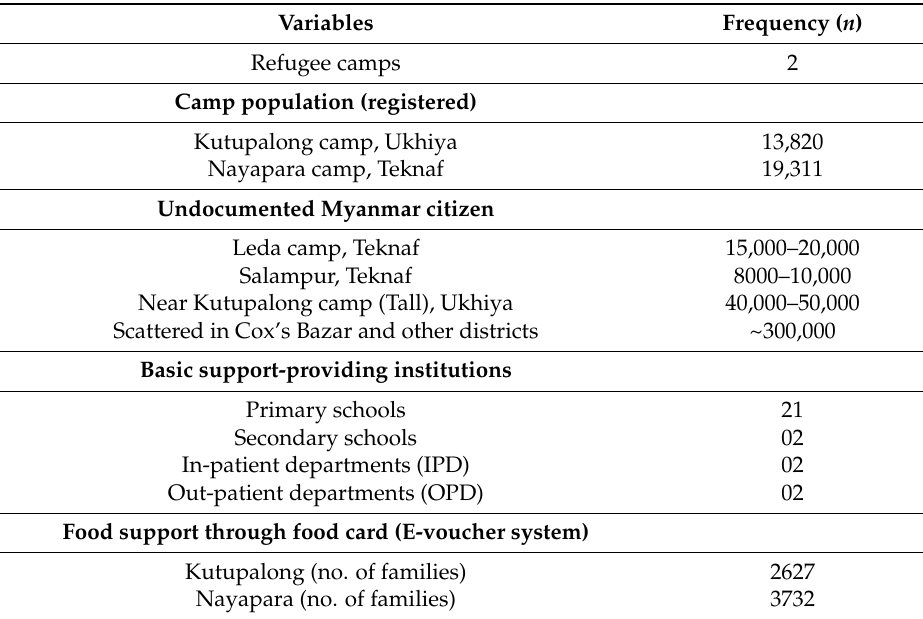
Table 1. Current information on refugees and undocumented persons from Myanmar currently in Bangladesh, RRRC, Bangladesh, 2015